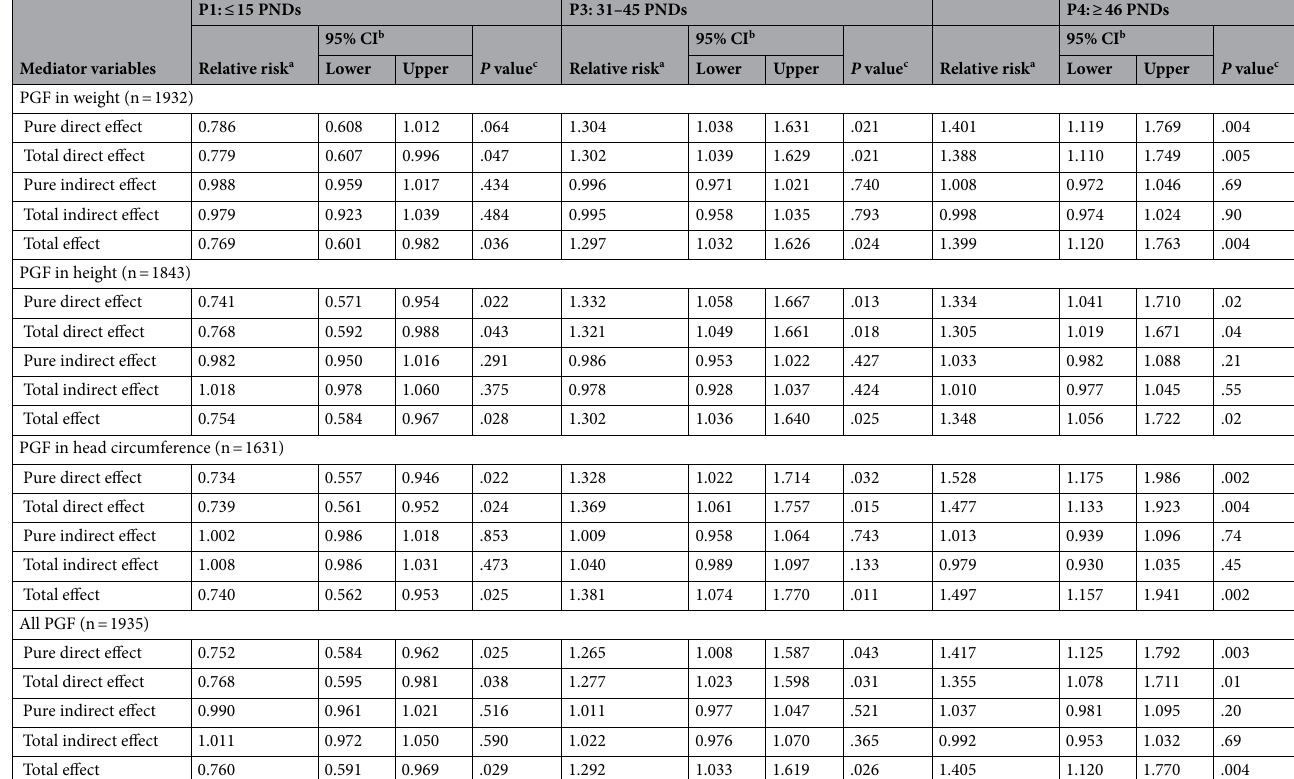
Table 2. Mediation analysis between time to full enteral feeding and neurodevelopmental delay by postnatal growth failure. PNDs, postnatal days; CI, confidence interval; PGF, postnatal growth failure. a It is assumed that gestational age, Apgar score at five min, small for gestational age, antenatal steroid use, and presence of pregnancy-induced hypertension, intraventricular hemorrhage (≥ grade 3), total sepsis, periventricular leukomalacia, bronchopulmonary dysplasia (≥ moderate), necrotizing enterocolitis (≥ 2b), and retinopathy of prematurity requiring laser therapy are sufficient to control for confounding. b 95% confidence intervals